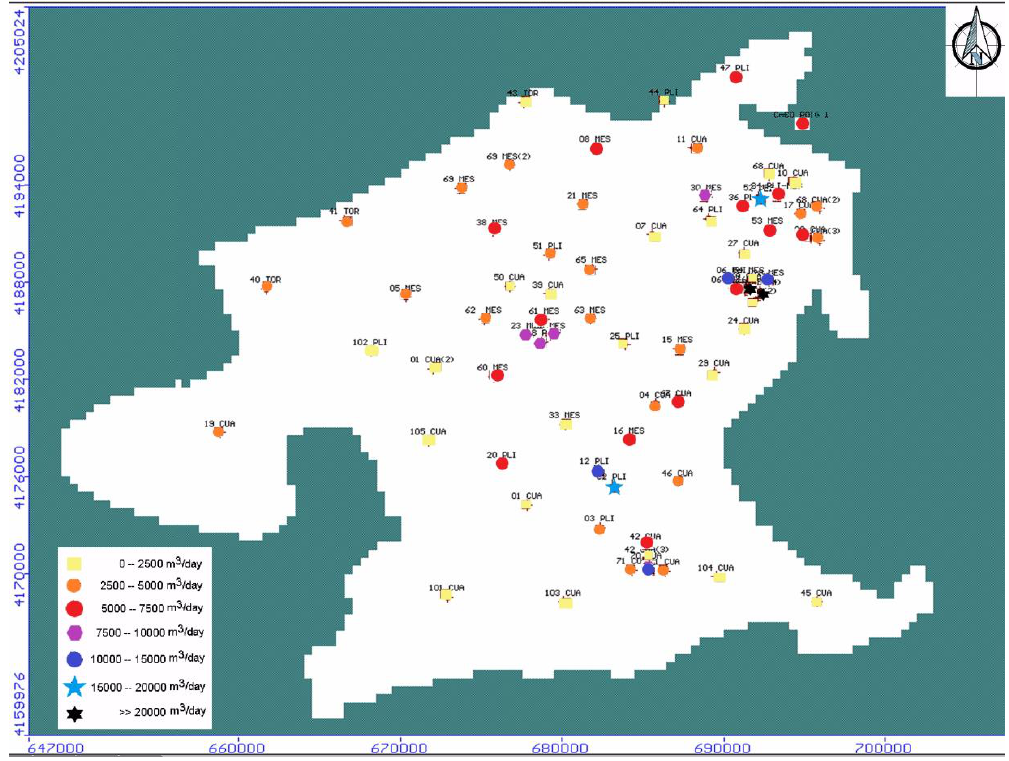
Figure 7. Spatial distribution of the groundwater withdrawal.